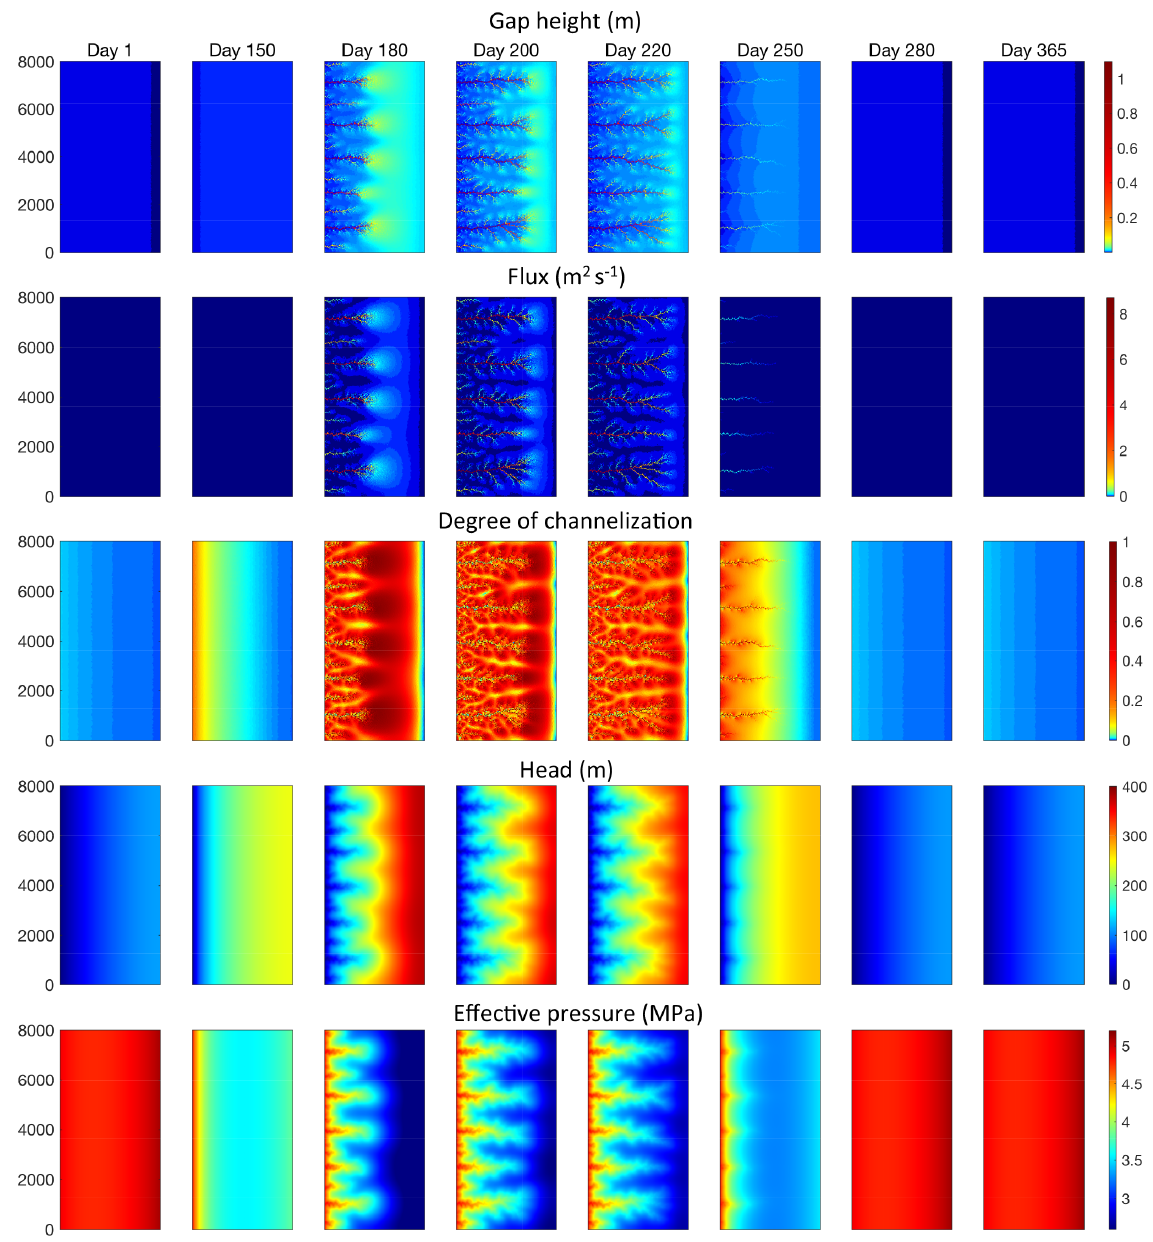
Figure 6. Seasonal evolution with distributed meltwater input as shown in Fig. 5 on a 4km by 8km domain over one full annual cycle. Self-organized efficient drainage pathways form from the outflow (left edge of the domain) as melt input increases, persist through the melt season, and collapse again as melt input decreases, returning to a steady sheet configuration. The efficient pathways show lower head (i.e., higher effective pressure) than their surrounding areas in the y